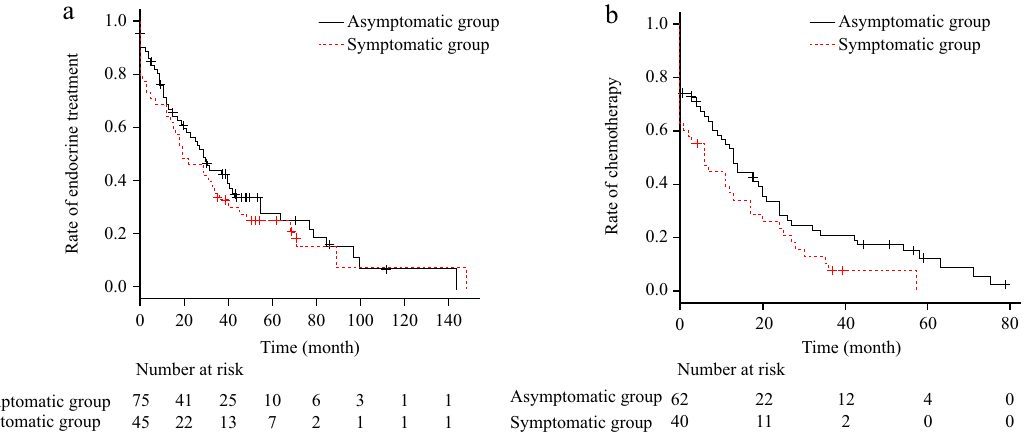
Figure 3. Treatment duration according to the asymptomatic/symptomatic luminal subtype. ( a ) Endocrine therapy, ( b )